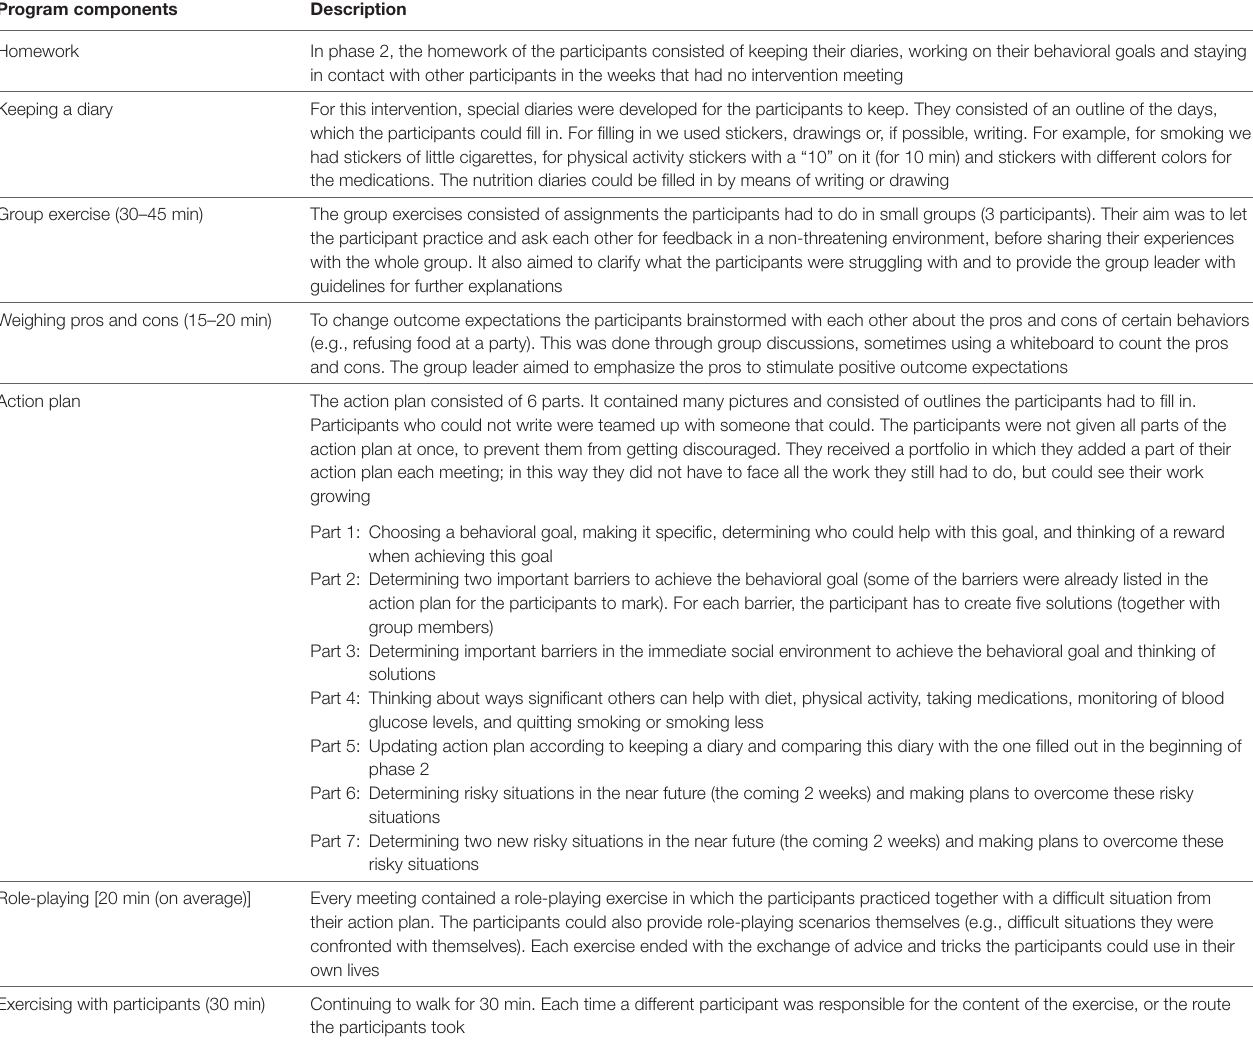
TaBle 5 | Program components: phase 2. Program components